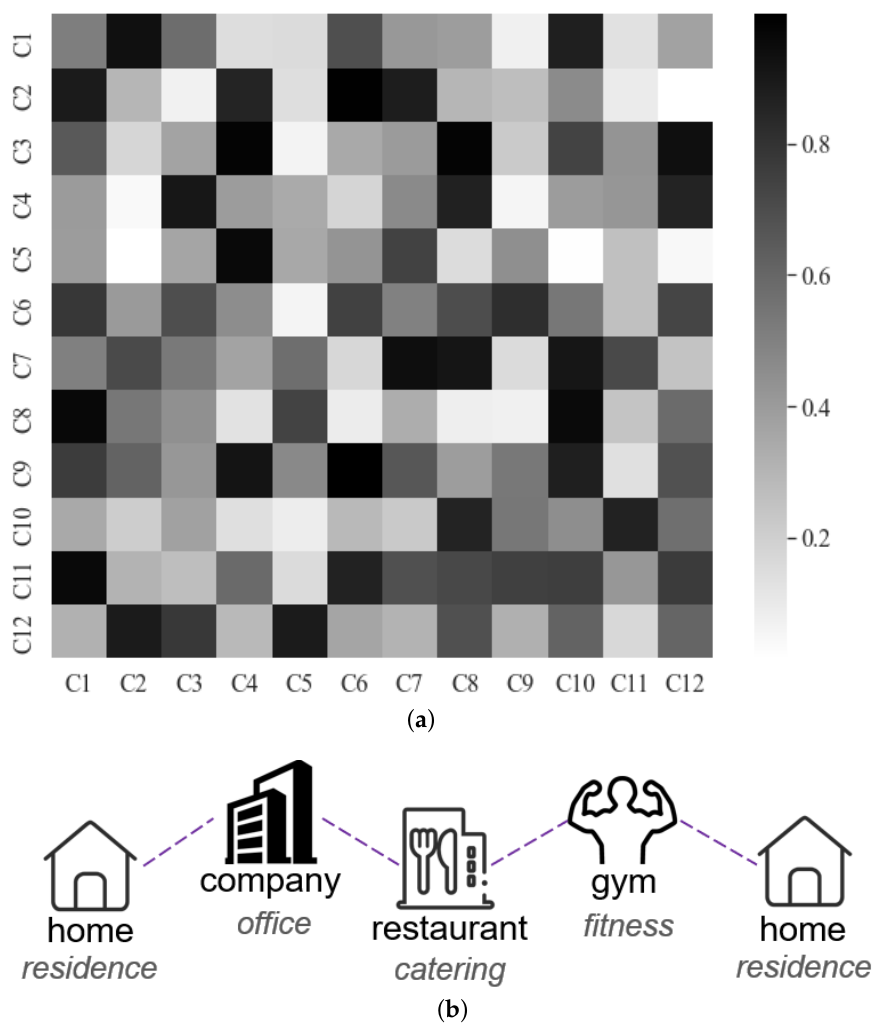
Figure 2. ( a ) Category transition probability of user’s check-ins in the Charlotte dataset (C1: